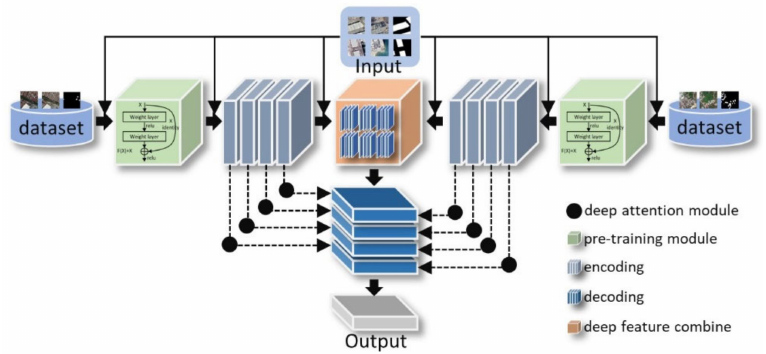
Figure 2. The architecture of TDA-Net.